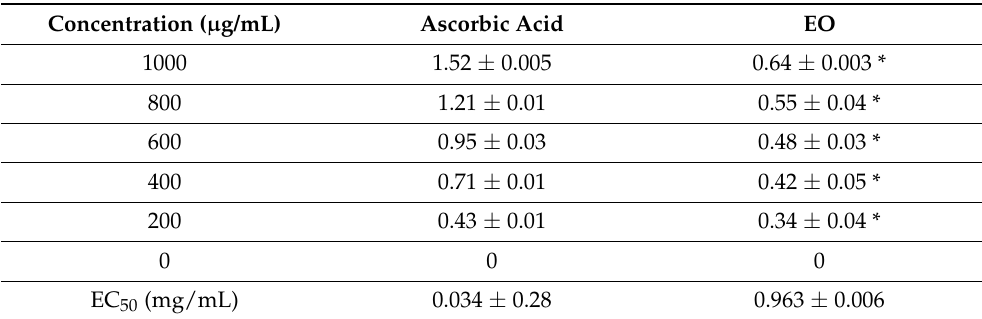
Table 3. Reducing ability and EC 50 values of Taraxacum officinale essential oil and ascorbic acid at different